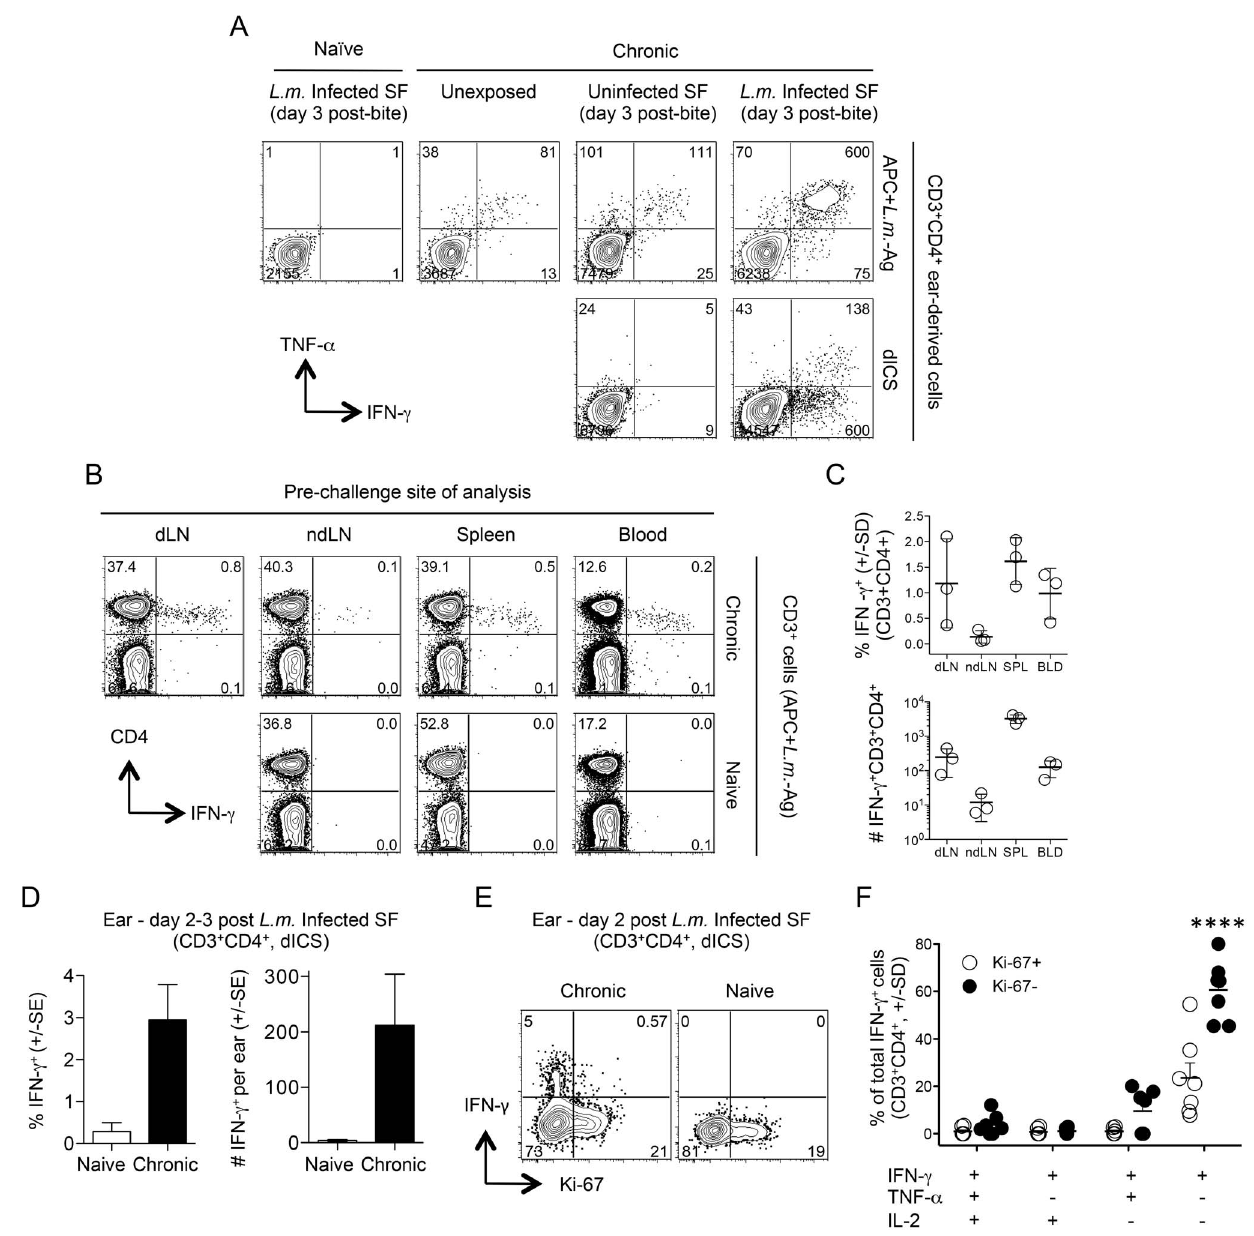
Figure 2. Analysis of the early concomitant immune response following exposure to the bites of L.major -infected sand flies. ( A, D–F ) Ears of naı¨ve mice (Naı¨ve) or uninfected ears of mice with a chronic primary infection in the left hind footpad (Chronic) were unexposed, or exposed to the bites of uninfected sand flies (Uninfected SF) or L. major infected sand flies ( L.m. Infected SF). 2–3 days later CD3 + CD4 + from single ears were analyzed by flow cytometry. ( A ) Representative intracellular staining for cytokine-producing cells after over-night (14 hours) in-vitro stimulation with APC + L.m. -Ag (top panels) or direct intracellular staining (dICS) (bottom panels) on day 3 post-challenge. Numbers indicate the number of cells per ear in each quadrant. ( B and C ) Cells from the indicated locations were isolated from perfused naive or chronic mice and stimulated with APC + L.m. -Ag. ( B ) Representative dot-plots of an individual naı¨ve or chronic mouse. Numbers represent the frequency of cells in each quadrant. ( C ) Percentage and relative # (per site or ml of blood) of IFN- c + cells from n=3 individual chronic mice. ( D ) Percentage or number of IFN- c + cells per ear following exposure to infected sand fly bites and dICS. Results are pooled from 3 independent experiments, n=10 (naı¨ve) or 11 (chronic) ears. ( E ) Representative dot-plot of IFN- c and Ki-67 expression following dICS. Numbers in dot plots represent frequency. ( F ) Cytokine-production as a function of Ki-67 expression by IFN- c + CD3 + CD4 + ear cells following dICS (n=7 ears). ****, p # 0.0001 versus all other groups. Data is representative of 3 similar experiments. doi:10.1371/journal.ppat.1004538.g002 labeled, CD4 + CD44 + CD62L + T CM or CD4 + CD44 + CD62L 2 cells, CD44 + CD62L + and CD44 + CD62L 2 Th cells were enriched for the which potentially contain both T EM and T EFF cells, were sorted Th1 markers T-bet and CXCR3, and the activation markers CD69, ICOS, and CD54 (ICAM-1) (Fig. S3A). Prior studies have shown from the spleens and dLNs of chronic mice and co-transferred into naı¨ve recipients (Fig. 4A and Fig. S2). Prior to transfer both IL-7R is rapidly re-expressed on effector CD4 + T cells after a period